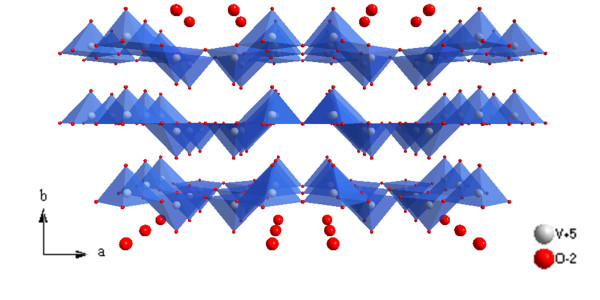
The crystal structure of orthorhombic V2O5 in projection along [001].